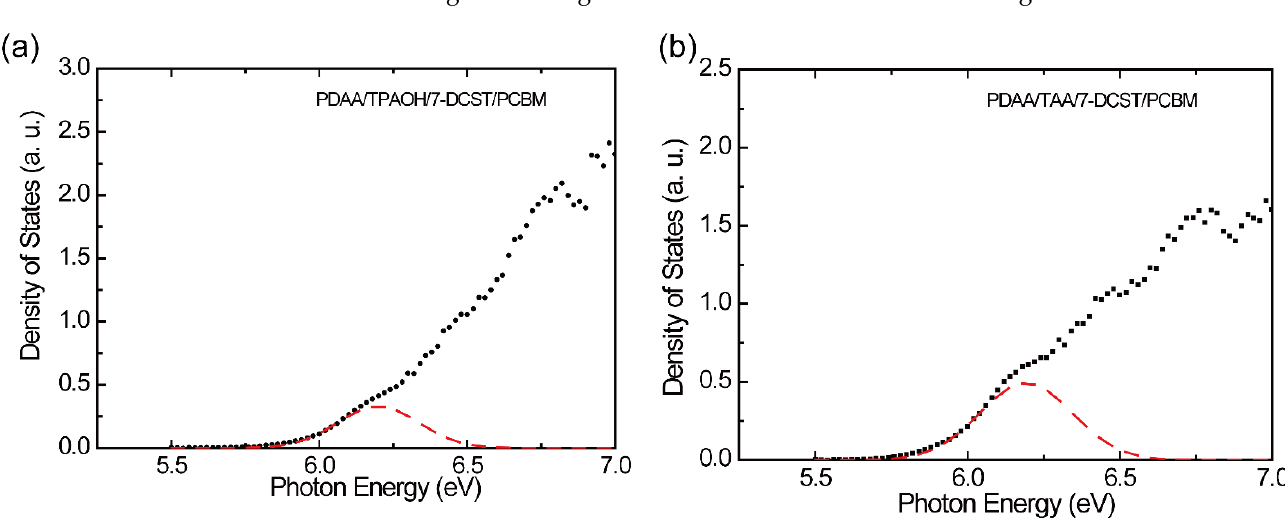
Figure 7. DOS curves are plotted as a function of photon energy for ( a ) PDAA/TPAOH/7-DCST/PCBM and ( b ) PDAA/TAA/7-DCST/PCBM: black solid curve, measured DOS curve; red curve, separated Gaussian curve at low photon energy region. Table 3. Summary of the DOS width and hole mobility. DOS Width